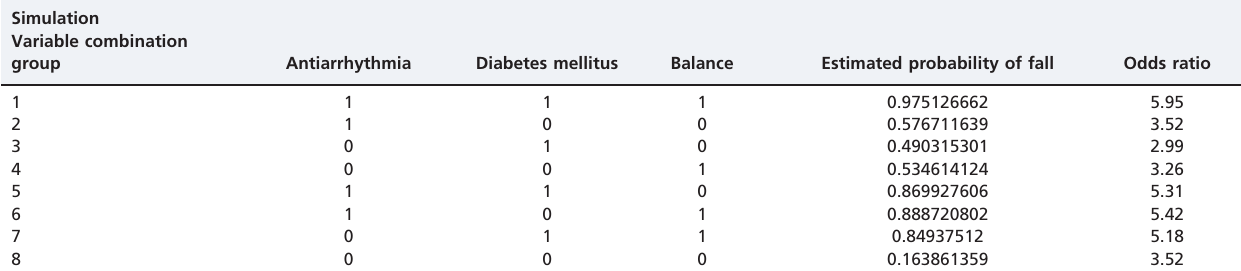
Table 3 - Probability of the risk of a fall according to the simulation of combinations of independent